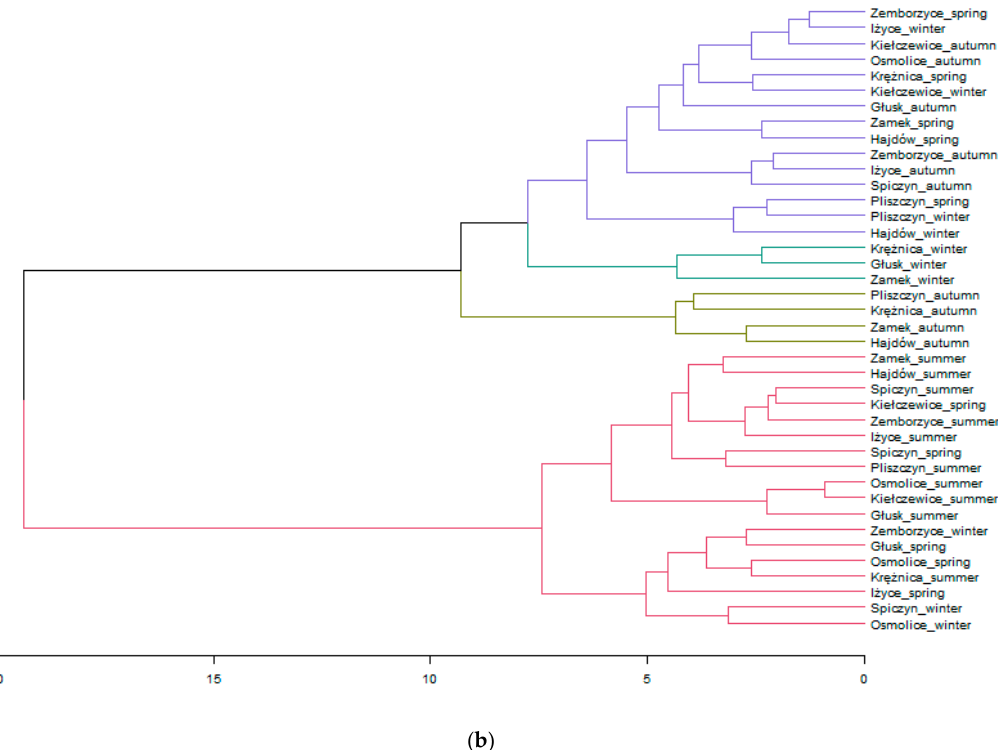
Figure 2. A dendrogram of the hierarchical cluster analysis based on the Euclidean measure and Ward’s method: ( a ) measuring stations, ( b ) measuring stations and seasons.